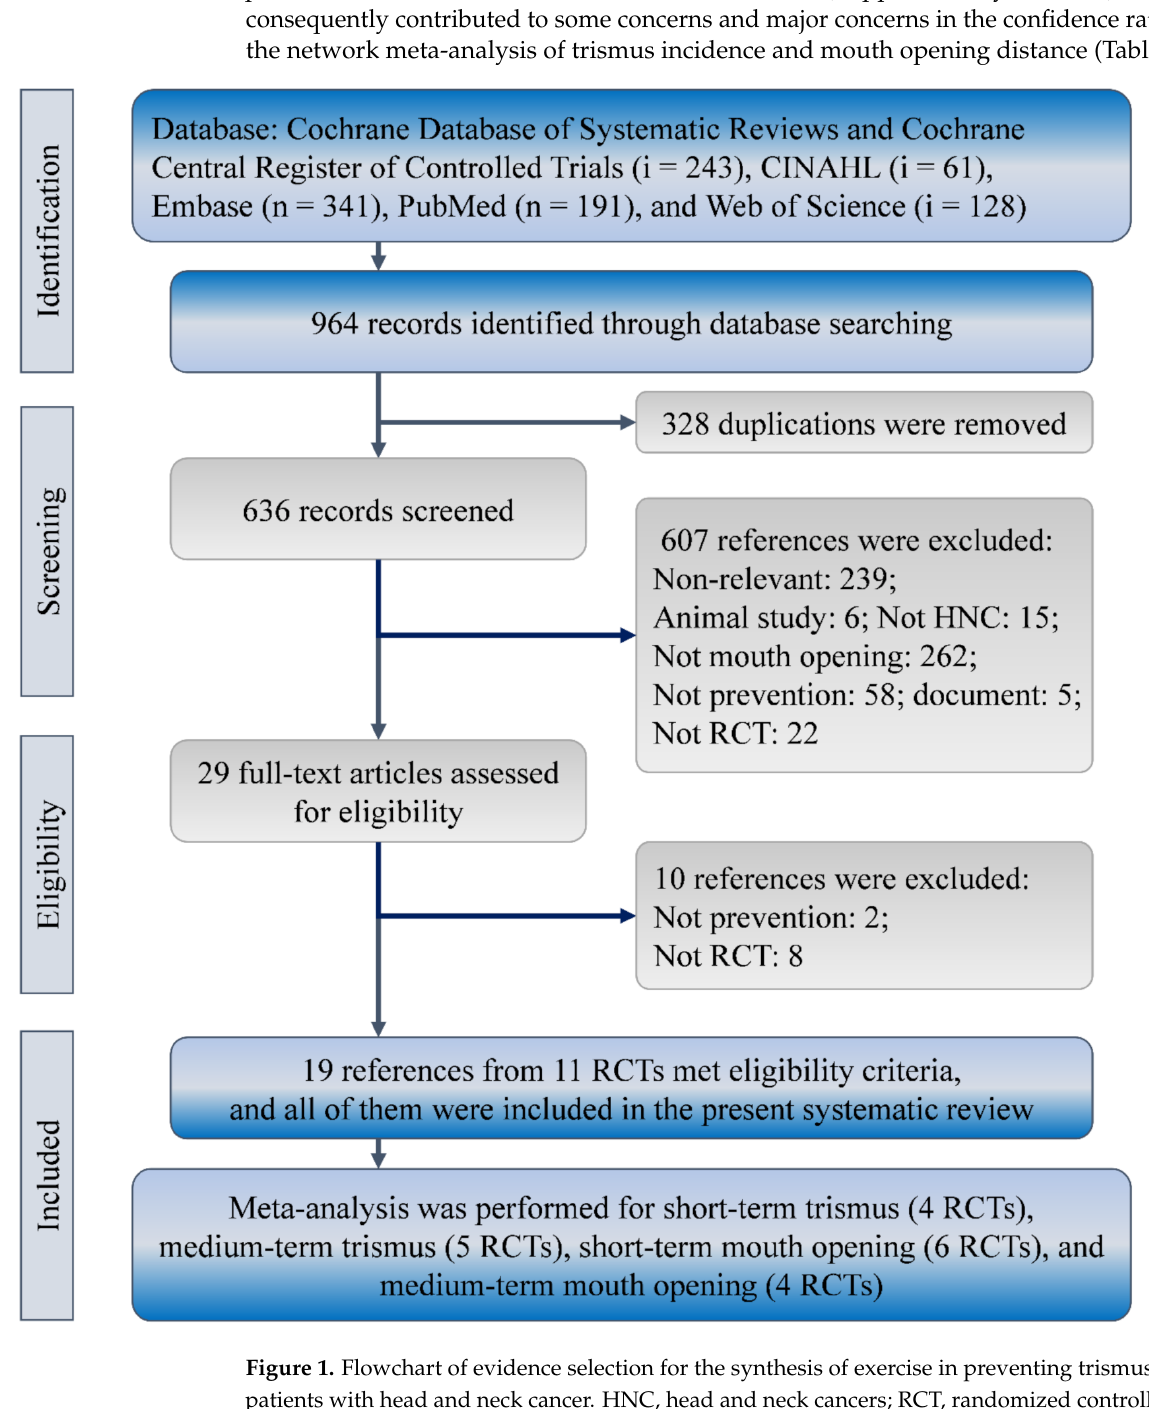
Figure 1. Flowchart of evidence selection for the synthesis of exercise in preventing trismus among patients with head and neck cancer. HNC, head and neck cancers; RCT, randomized controlled